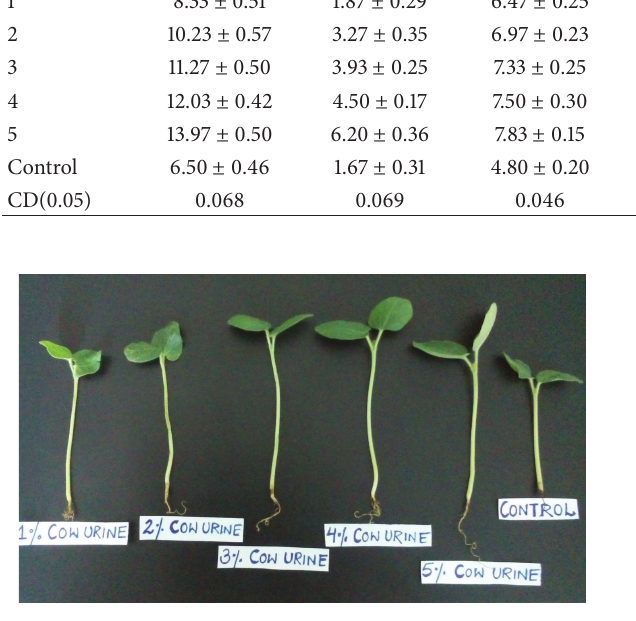
Figure 2: Effect of different concentrations (1%, 2%, 3%, 4%, and 5%) of cow urine on Trigonella foenum-graecum (Methi) after 25 days.